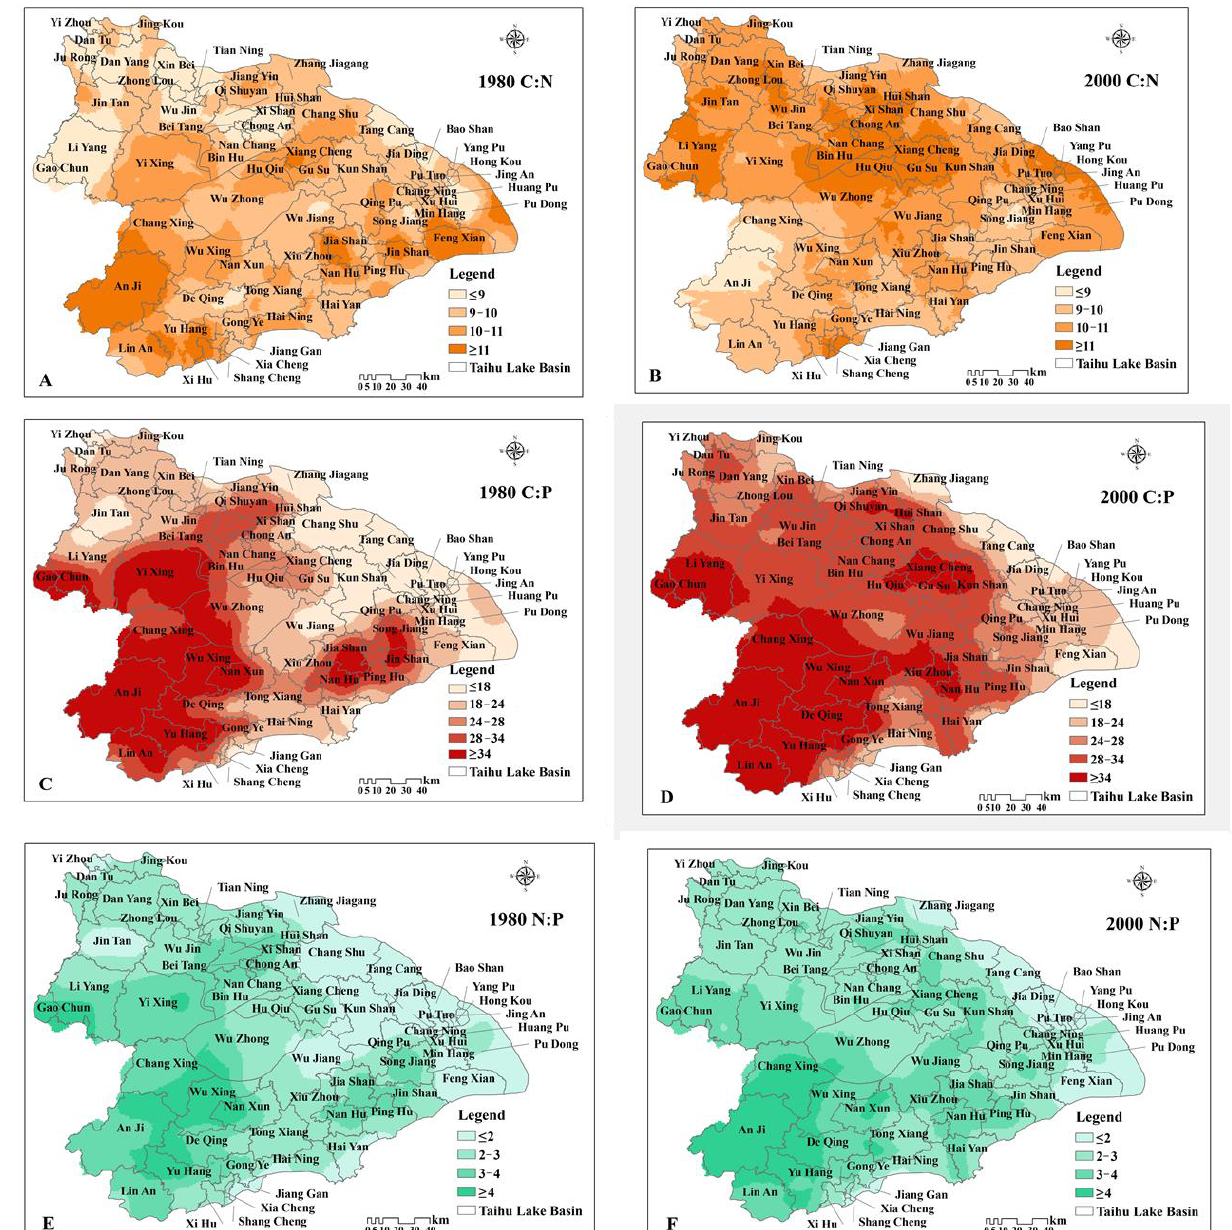
Figure 2. Temporal and spatial distribution of topsoil C:N, C:P, and N:P in 1980s ( A , C , E ) and 2000s ( B , D , F ), respectively, in Taihu Lake basin.